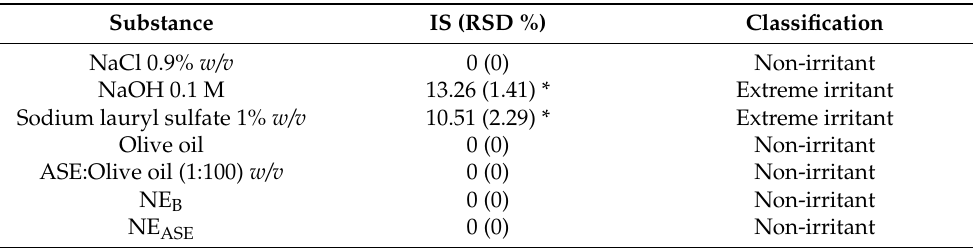
Table 3. Irritant score and irritancy classification in the hen’s egg chorioallantoic membrane test (HET-CAM) ( n = 5).